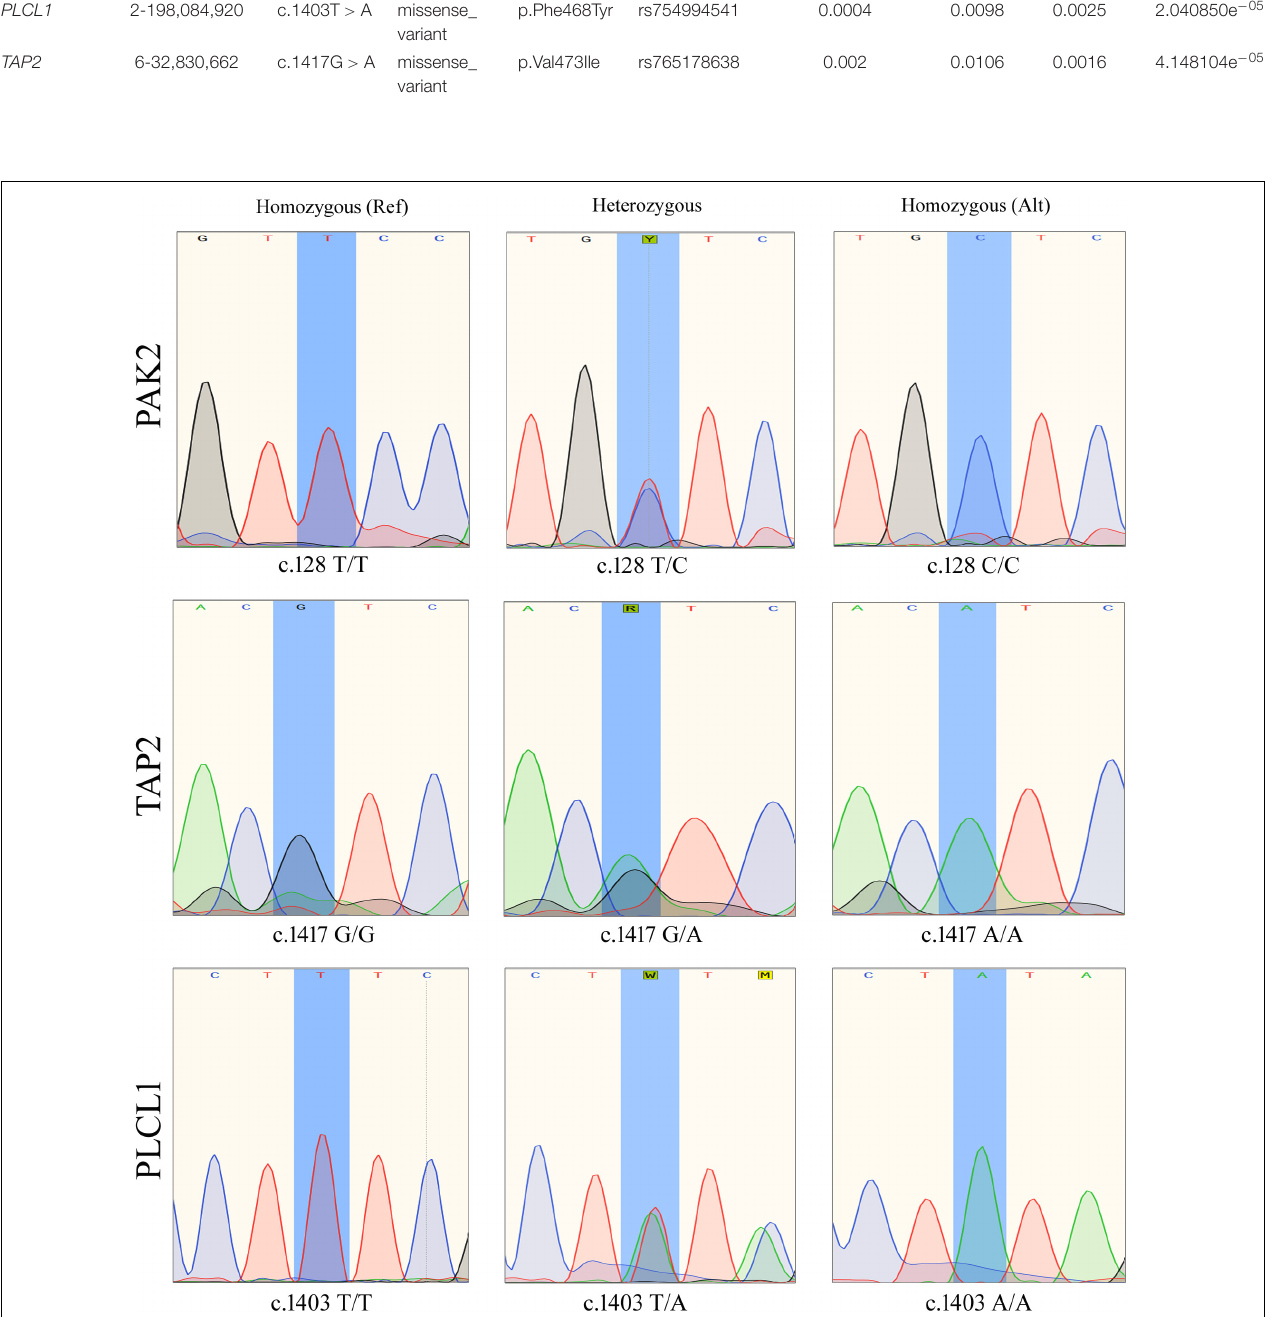
Frontiers in Pediatrics |